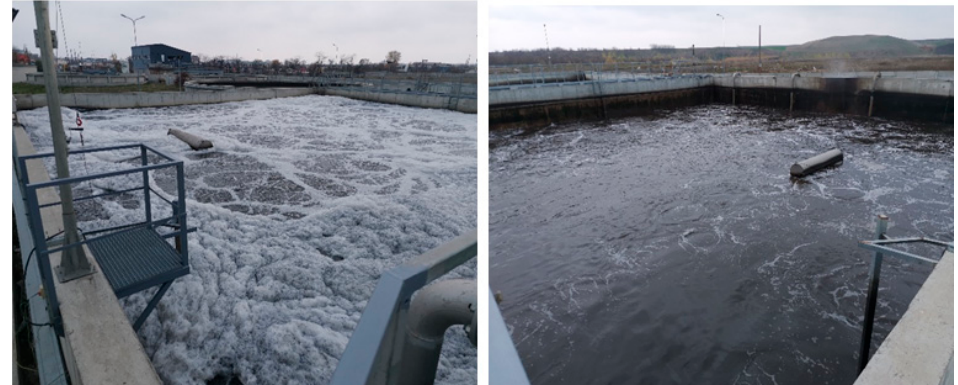
Figure 3. Activated sewage sludge basin (sequential biological reactors).